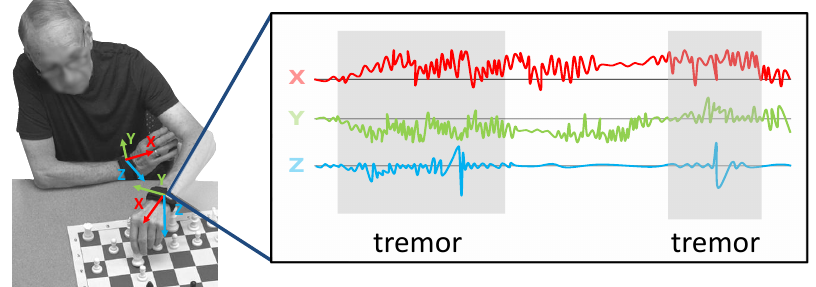
Figure 1. Automated tremor detection with wearable sensors during everyday